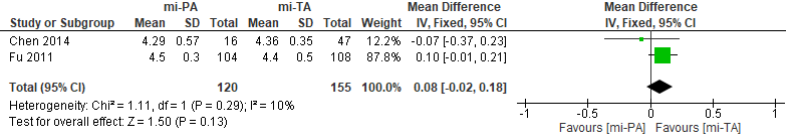
( h ) Forest plot representing analysis of postoperative mean potassium serum levels (mmol/L).